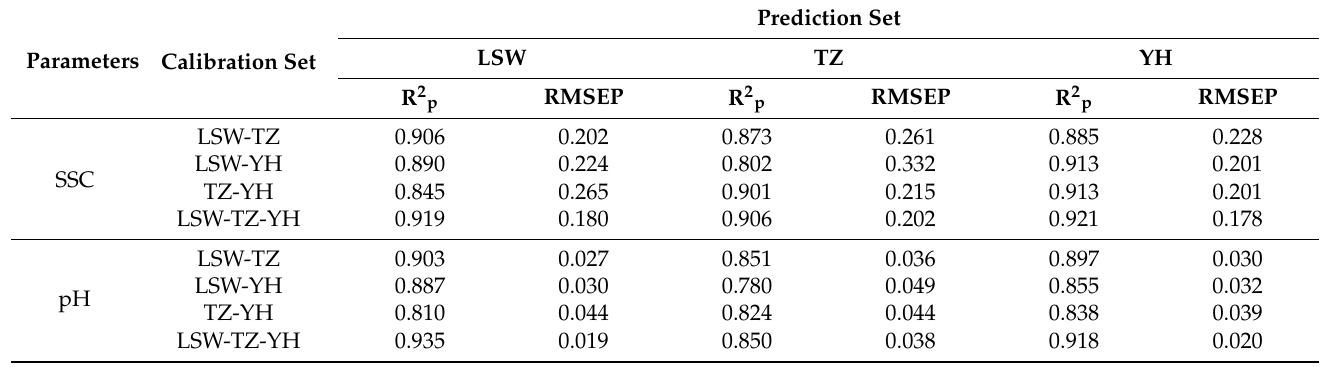
Table 5. Predicted results of the soluble solids content (SSC) and acidity (pH) detection model for hybrid (mix) pear